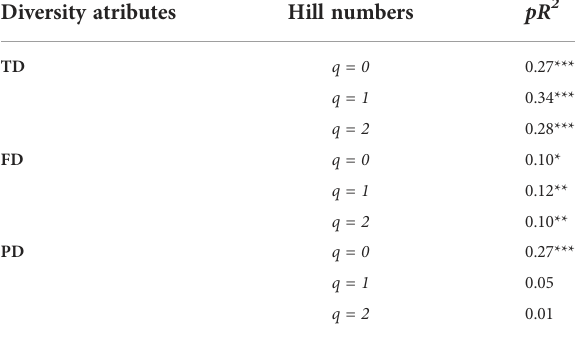
TABLE 2 Pseudo R-squared ( pR 2 ) values for negative binomial generalized linear models (GLMs) between latitude and diversity attributes for different Hill numbers: taxonomic diversity (TD), functional diversity (FD) and phylogenetic diversity (PD). Diversity atributes